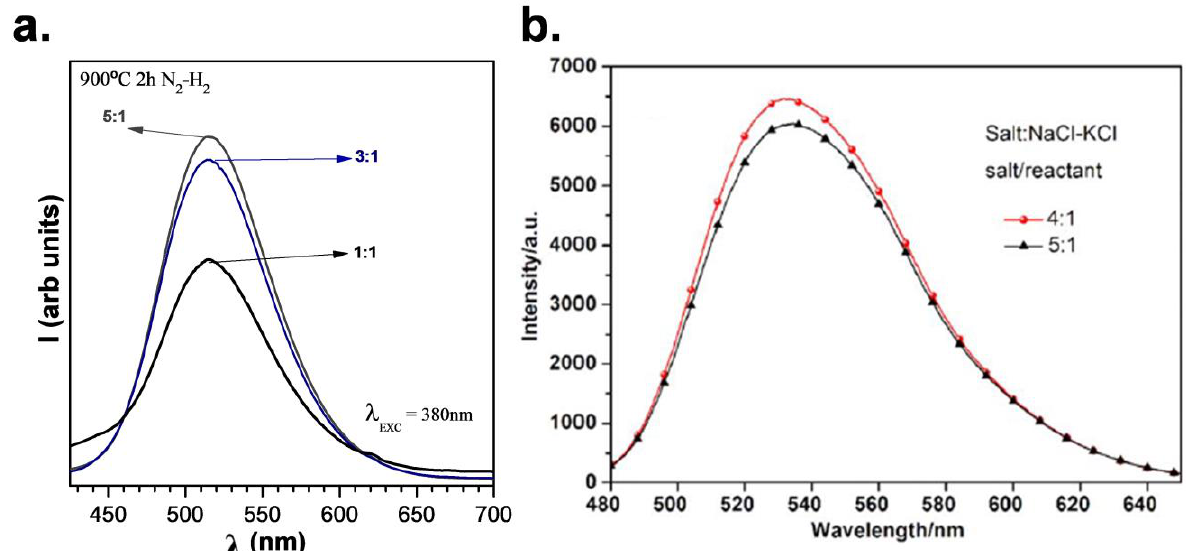
Materials 2021 , 14 , x FOR PEER REVIEW Figure 2. ( a ) Photoluminescence emission spectra as a function of the salt/SrAl 2 O 4 molar ratio of 1:1, 3:1, and 5:1 of SrAl 2 O 4 :Eu, Dy phosphor synthesized at 900 °C. ( b ) Emission spectra of Ce 3+ doped yttrium aluminum garnet using salt-to-reactant molar ratios of 4:1 and 5:1. Reprinted with permission from [34]. Copyright 2019, IOP Publishing, Ltd.